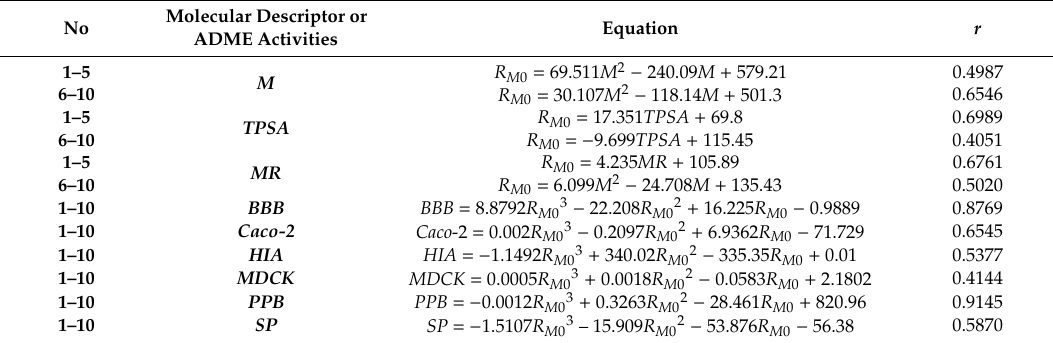
Table 5. The correlation of the R M 0 values with the molecular descriptors and predicted ADME activities for compounds 1–10 .